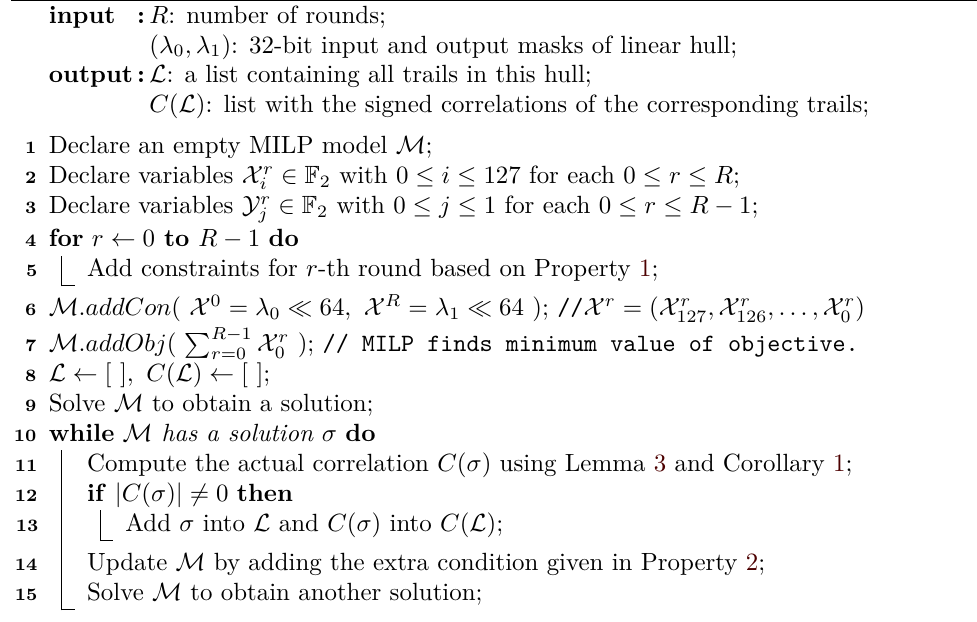
Algorithm 1: Searching All Trails in a Given Linear Hull for P b [ l 1